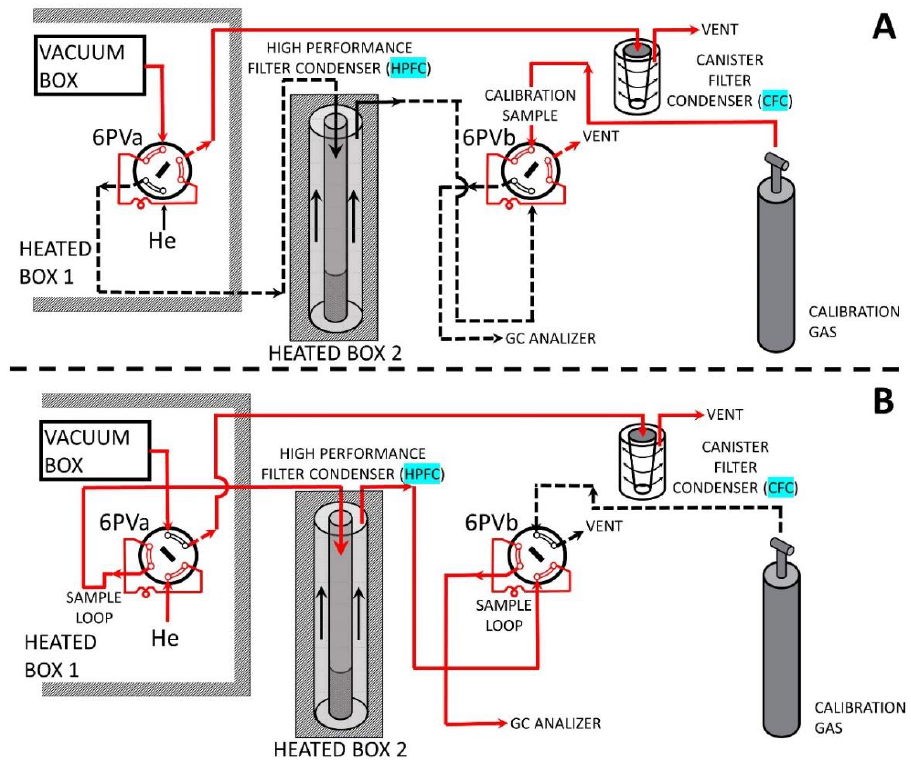
Figure 9. Schematic Description of the CREC Riser Simulator Auxiliary Equipment Operation, showing the High-Performance Filter Condenser (HPFC) and the Canister Filter Condenser (CFC) and the Two Possible Operational Stages: Steps ( A , B ). The included 6 PVb is used in every run for calibration with a known amount of methane.